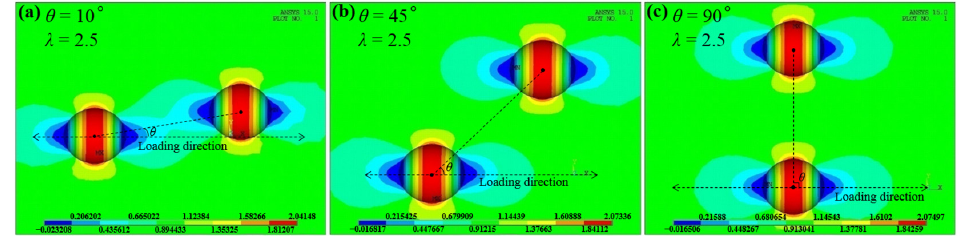
Figure 8. The comparison of stress contours with different θ for the P se -P id case ( d 1 = d 2 = 50 μ m) when λ = 2.5, showing little interacting effect between these two pits. ( a ) For θ = 10°; ( b ) for θ = 45°; and ( c ) for θ = 90°.